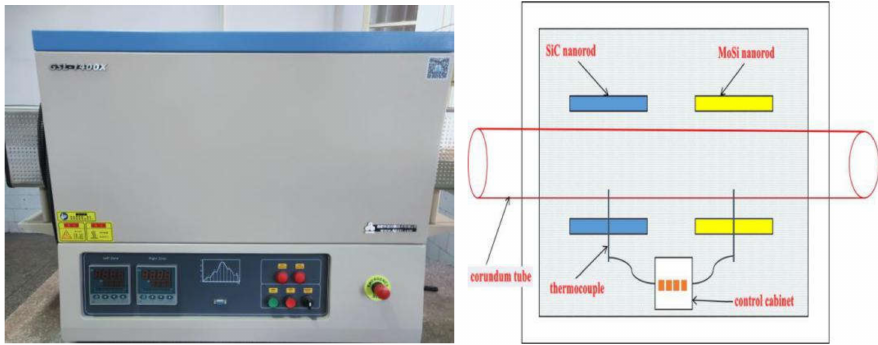
Figure 2. The diagram of the main experimental setup (horizontal tube